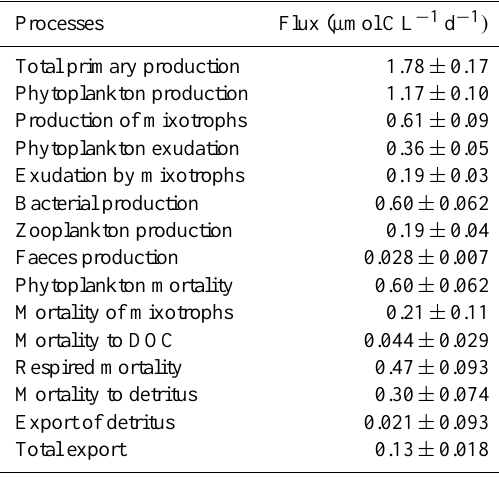
Table 3. Carbon fluxes (µmolCL − 1 d − 1 ) in phase 1 ( t 0 − 12 ) de- rived from the model between the major carbon pools, shown as arrows in Fig. 7. The values present the average ± standard devia- tion of all mesocosms ( n = 9).